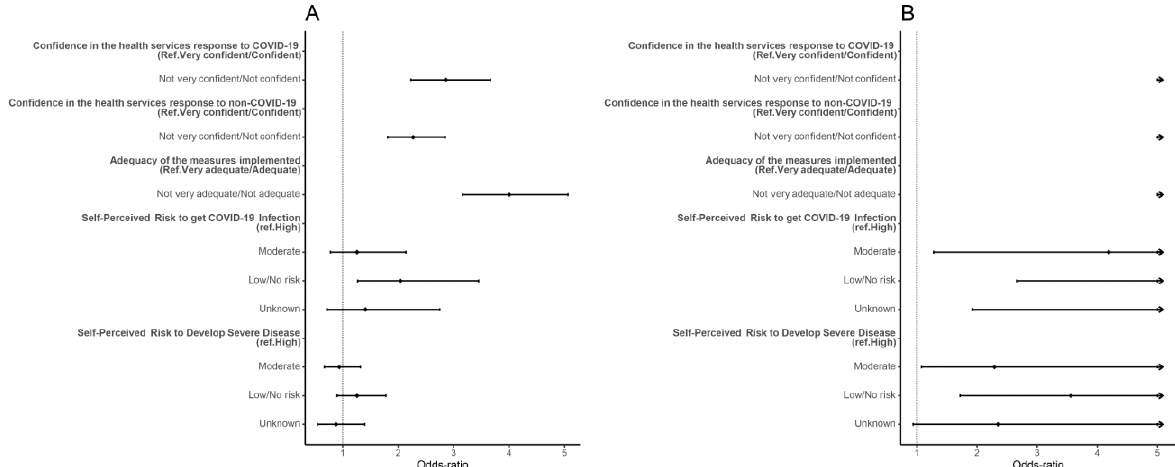
Figure 3. Forest plot of vaccine hesitancy for COVID-19 influences. Adjusted odds ratio (adjusted for gender, age, education, and period of questionnaire) and the respective 95% confidence intervals are denoted by black dots and black lines, respectively. Forest plot confidence intervals and estimates were cut off at 5. ( A ) Results of the main analysis — vaccinated vs. hesitant (refuse, undecided and would take the vaccine); ( B ) results for the sensitivity analysis, removing individuals who would take the vaccine.